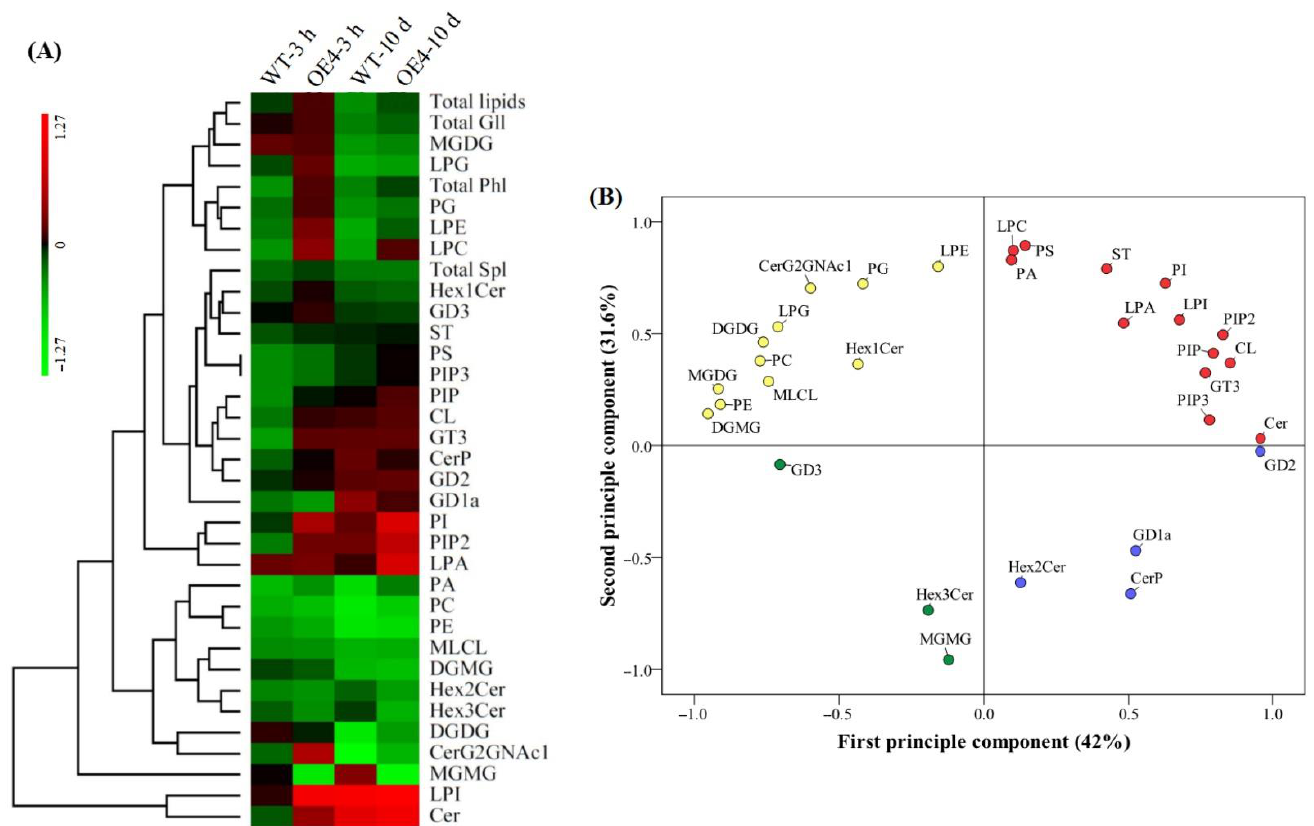
Figure 5. Changes in ( A ) heatmap as demonstrated by log 2 (fold change in contents of total lipids, lipid groups, and lipid classes) and ( B ) principal component analysis (PCA) based on 31 different lipid classes in leaves of wild type (WT) and transgenic Arabidopsis thaliana (OE4) overexpressing the TrSAMS involved in spermidine biosynthesis in response to spermidine and heat stress. The heat map was made based on log 2 fold change of heat-stressed plants (3 h and 10 d) as compared to non-stressed plants (0